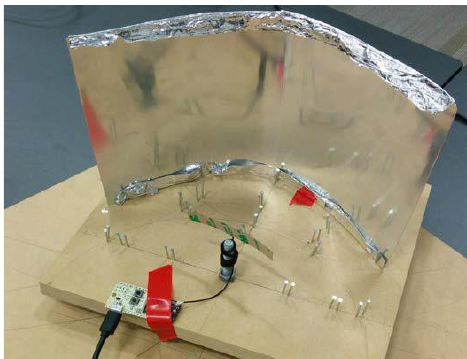
Figure 5. Test prototype for testing the gain of a single receiver node which is mounted on a rotational platform at a fixed position relative to the transmitter, but allowing varying orientation.